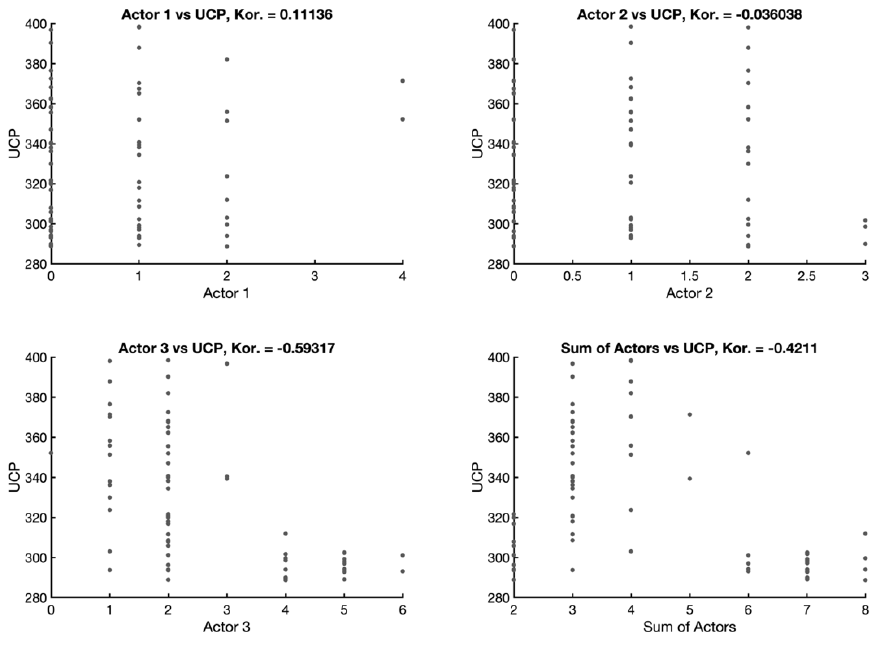
Figure 6. Correlation between actors and real size in UCP.